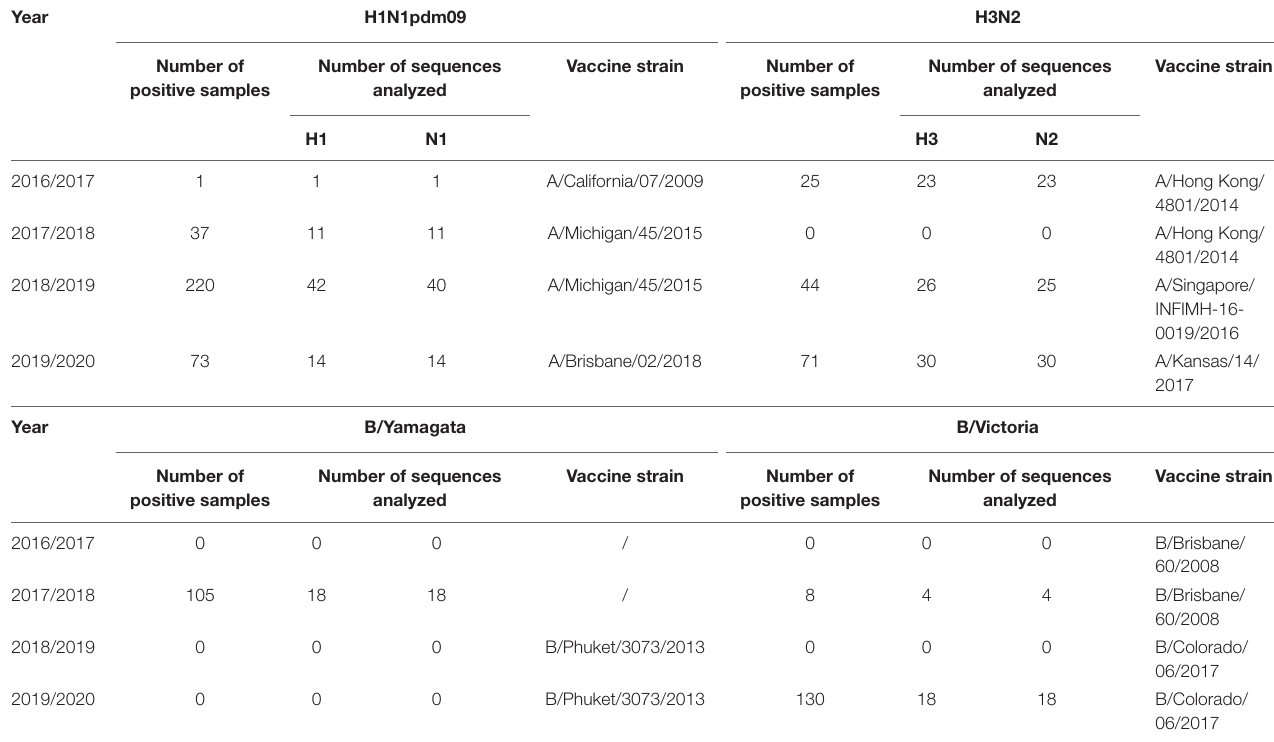
TABLE 3 | Total number of influenza A and B positive samples and number of HA/NA sequences analyzed in this study. Year H1N1pdm09 H3N2 Number of Number of sequences Vaccine positive samples analyzed